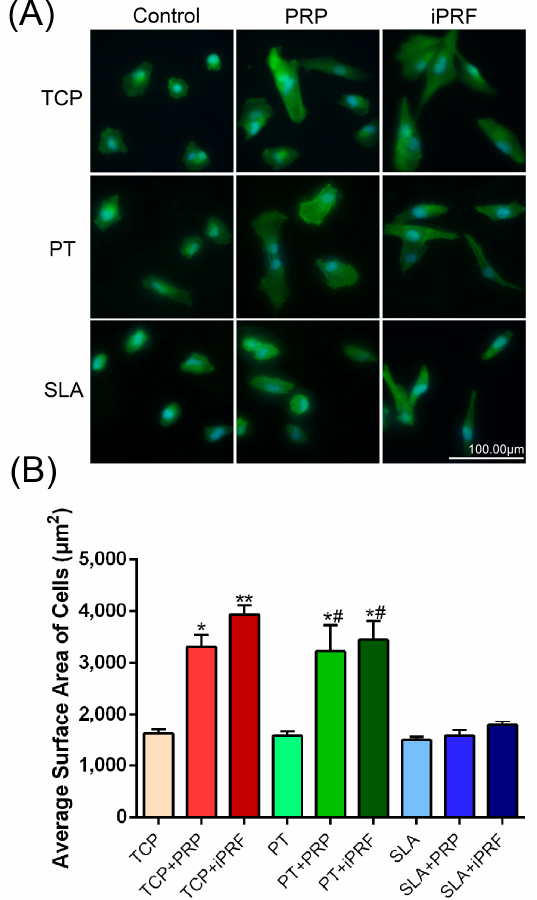
Figure 4. Effects of surface topography in combination with PRP and i-PRF on the morphology of human gingival fibroblasts ( A ) Human gingival fibroblasts cultured with and without PRP or i-PRF at 8 h were stained for F-actin (green) and nuclei (blue) (Scale bars = 100 µm); ( B ) Average surface planar area of cells. (* denotes significant difference between control and experimental group, p < 0.05; ** denotes significantly higher than all other groups, p < 0.05; # denotes significant difference between PT and SLA surfaces, p < 0.05).